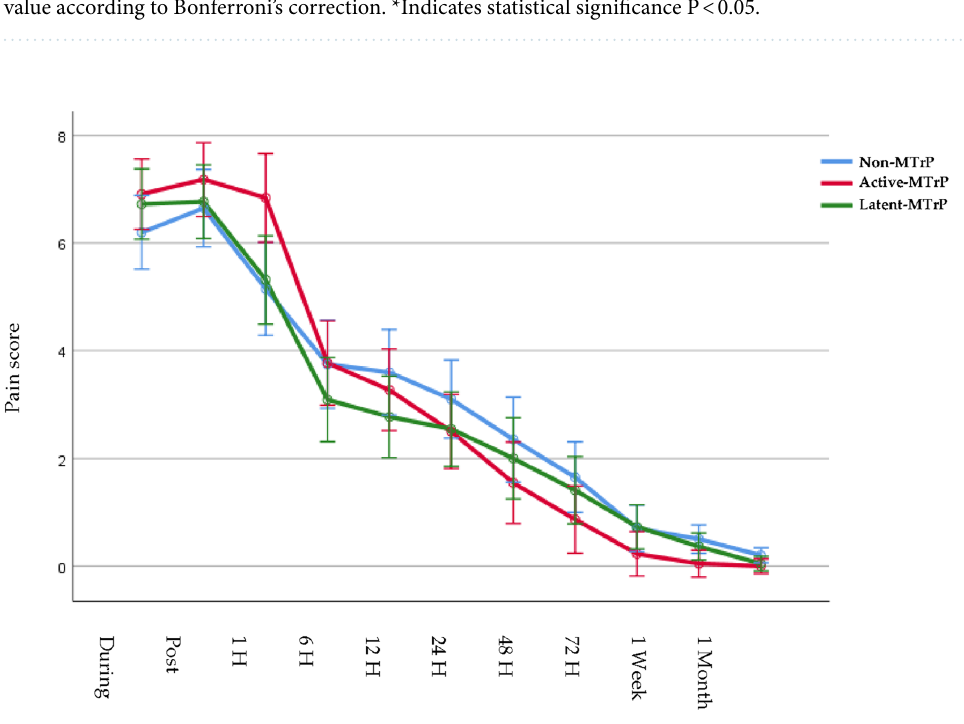
Figure 2. Pain intensity at 1